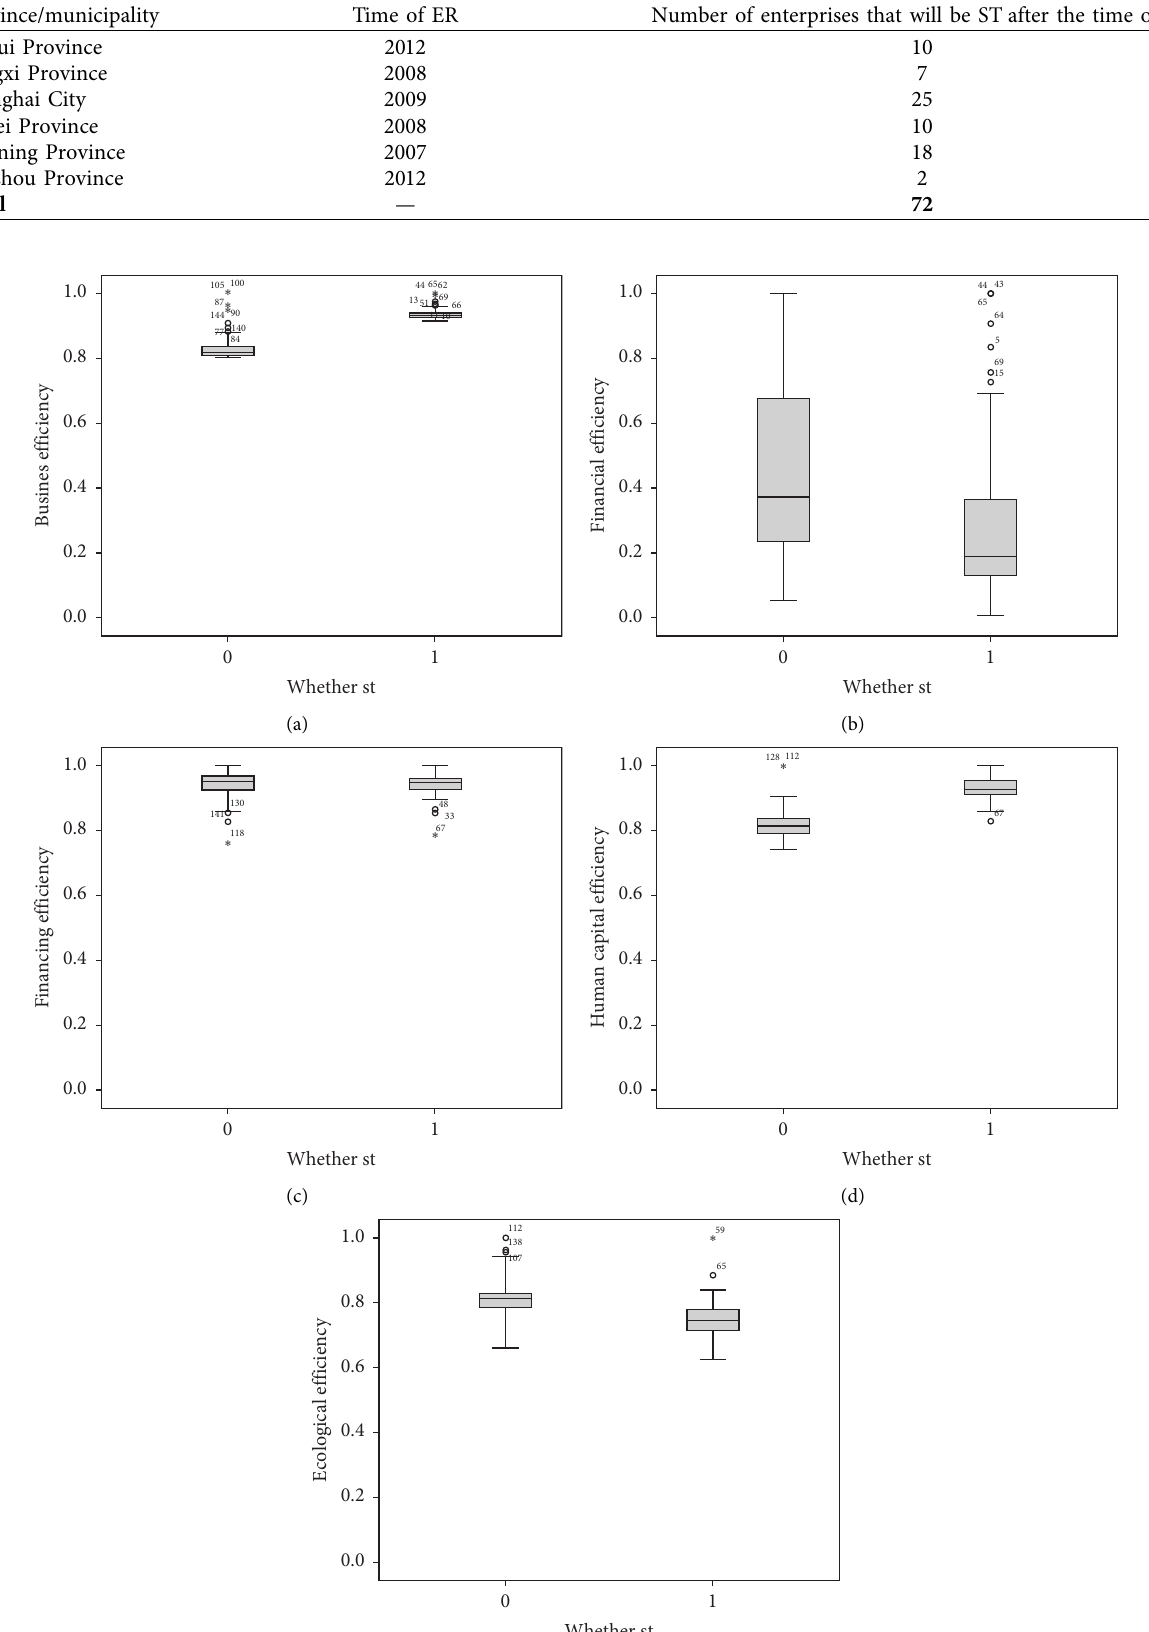
Table 3: Selection of